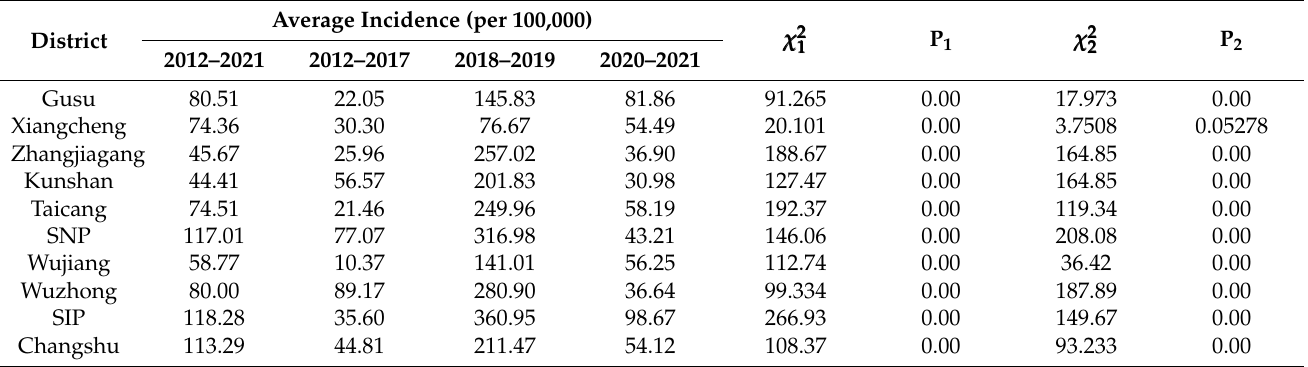
Table 2. The incidence rates of varicella by district in Suzhou, China, 2012–2021.